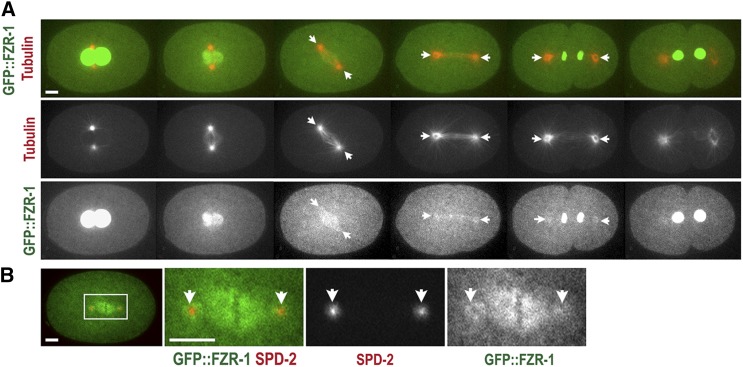
Subcellular localization of FZR-1 during the first cell cycle. (A) Still images from time-lapse movie of an embryo expressing GFP::FZR-1 and mCherry::tubulin. Movie was acquired at 1-min intervals. GFP::FZR-1 localizes at nuclei, mitotic spindles, and centrosomes (arrows). Expression of mCherry::tubulin used as a subcellular land-marker. (B) Embryo expressing GFP::FZR-1 and mCherry::SPD-2 displays that GFP::FZR-1 localizes to mitotic spindles and centrosomes (arrows) that colocalize with mCherry-SPD-2, a centrosome marker. Bar, 5 μm.